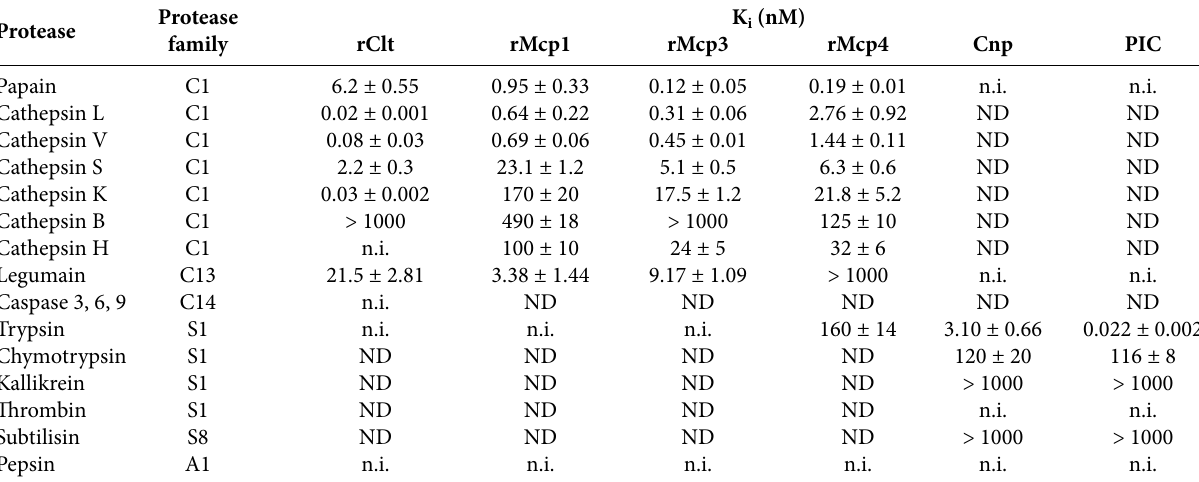
Table 3. Kinetic constants for the interaction of mycocypins and mycospins with various proteases. 17,20,22,23,30 Standard deviations are given where appropriate. rClt, recombinant clitocypin; rMcp1, recombinant macrocypin 1; rMcp3, recombinant macrocypin 3; rMcp4 recombinant macrocypin 4; Cnp, recombinant cnispin; PIC, recombinant cospin; n.i., no inhibition; ND, not determined.